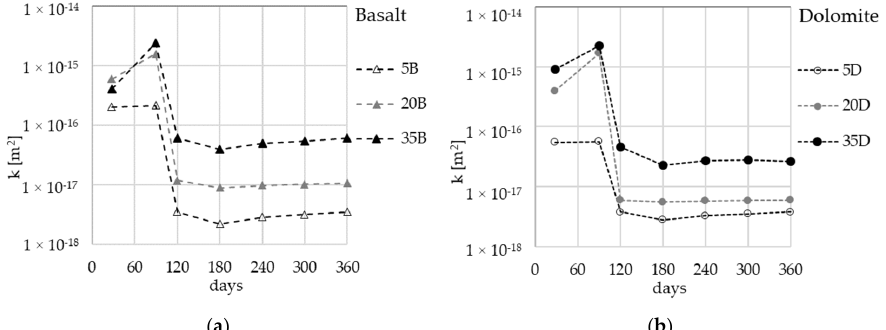
Figure 1. Gas permeability development in time for samples stored in room conditions: ( a ) basalt aggregate; ( b ) dolomite aggregate. aggregate; ( b ) dolomite